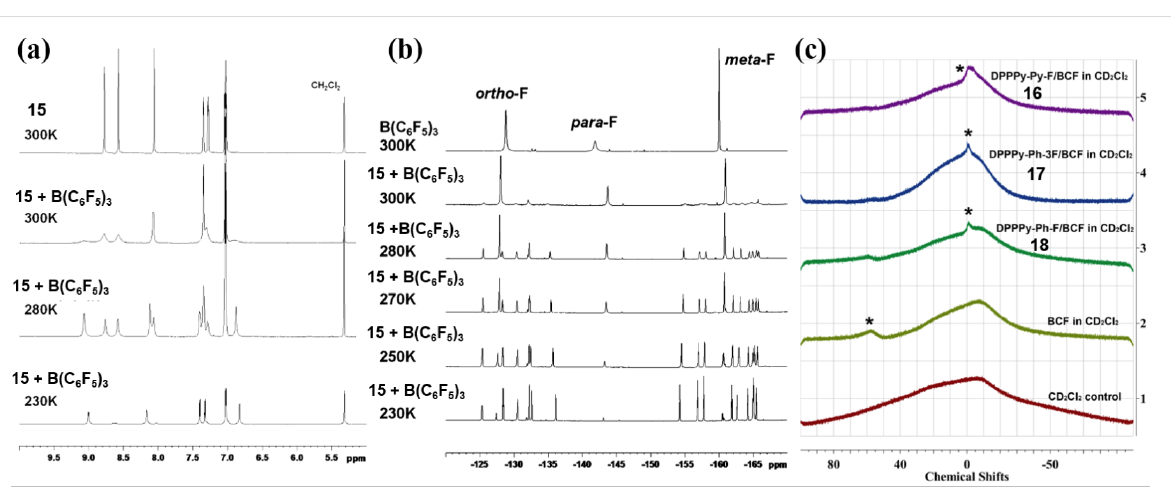
Figure 9: (a) 1 H NMR spectra in the aromatic region and (b) 19 F NMR spectra of compound 15 (top) and the mixture with 1 equivalent B(C 6 F 5 ) 3 at dif- ferent temperatures from 300 to 230 K. (c) 11 B NMR spectra of B(C 6 F 5 ) 3 , DPPPy-Py-F (compound 16 )/B(C 6 F 5 ) 3 , DPPPy-Ph-3F (compound 17 )/ B(C 6 F 5 ) 3 , and DPPPy-Ph-F (compound 18 )/B(C 6 F 5 ) 3 in CD 2 Cl 2 , respectively. Figure 9a and 9b were reprinted with permission from [43], Copyright 2011 American Chemical Society. This content is not subject to CC BY 4.0. Figure 9c was reprinted from [44], Dyes and Pigments, vol. 153, by J. Huang; Y. Li, Y. Wang; H. Meng; D. Yan; B. Jiang; Z. Wei; C. Zhan, “A Lewis acid-base chemistry approach towards narrow bandgap dye molecules”, pages 1–9, Copyright (2018), with permission from Elsevier. This content is not subject to CC BY